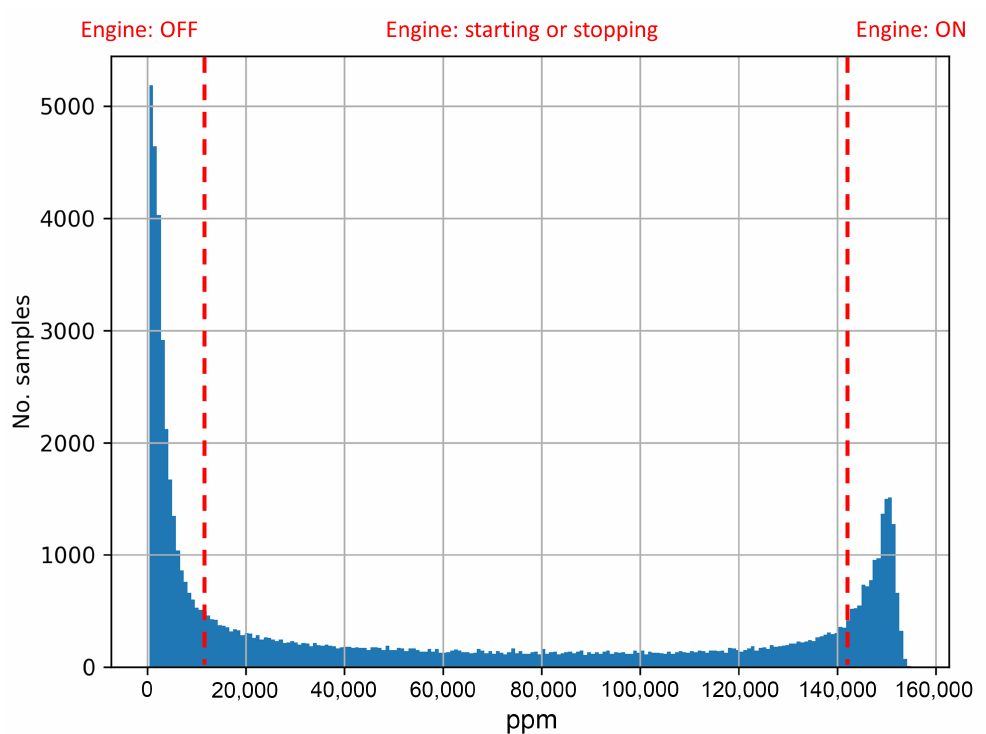
Figure 4. Histogram of CO 2 concentration (ppm) present in the